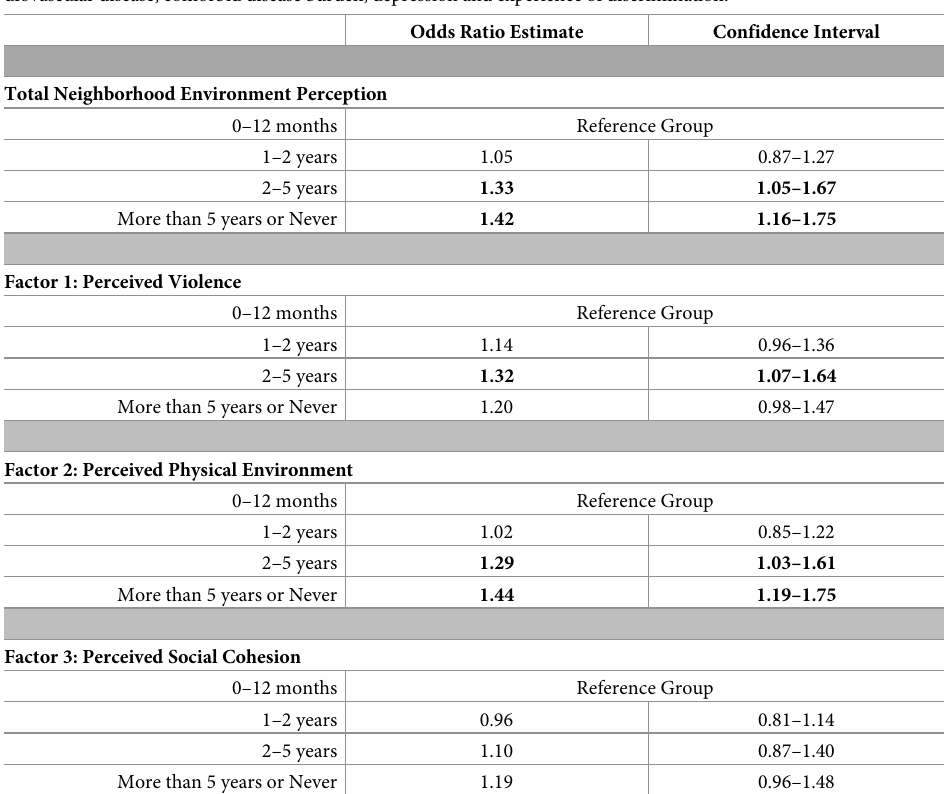
Table 4. Odds ratios of reporting routine check-up as related to neighborhood environment perception and sub- factors. Reference group reports most recent routine check-up within past year (0–12 months). Final model adjusted for age, sex, race/ethnicity, marital status, income, education, neighborhood deprivation index, insurance status, car- diovascular disease, comorbid disease burden, depression and experience of